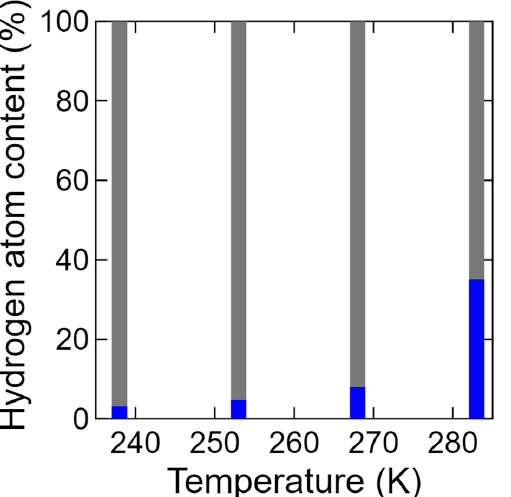
Figure 15. Temperature dependence of the ratio between the mobile (blue) and immobile (gray) hydrogen atoms at 238, 253, 268, and 283 K, as determined from Equations (5) and (6).